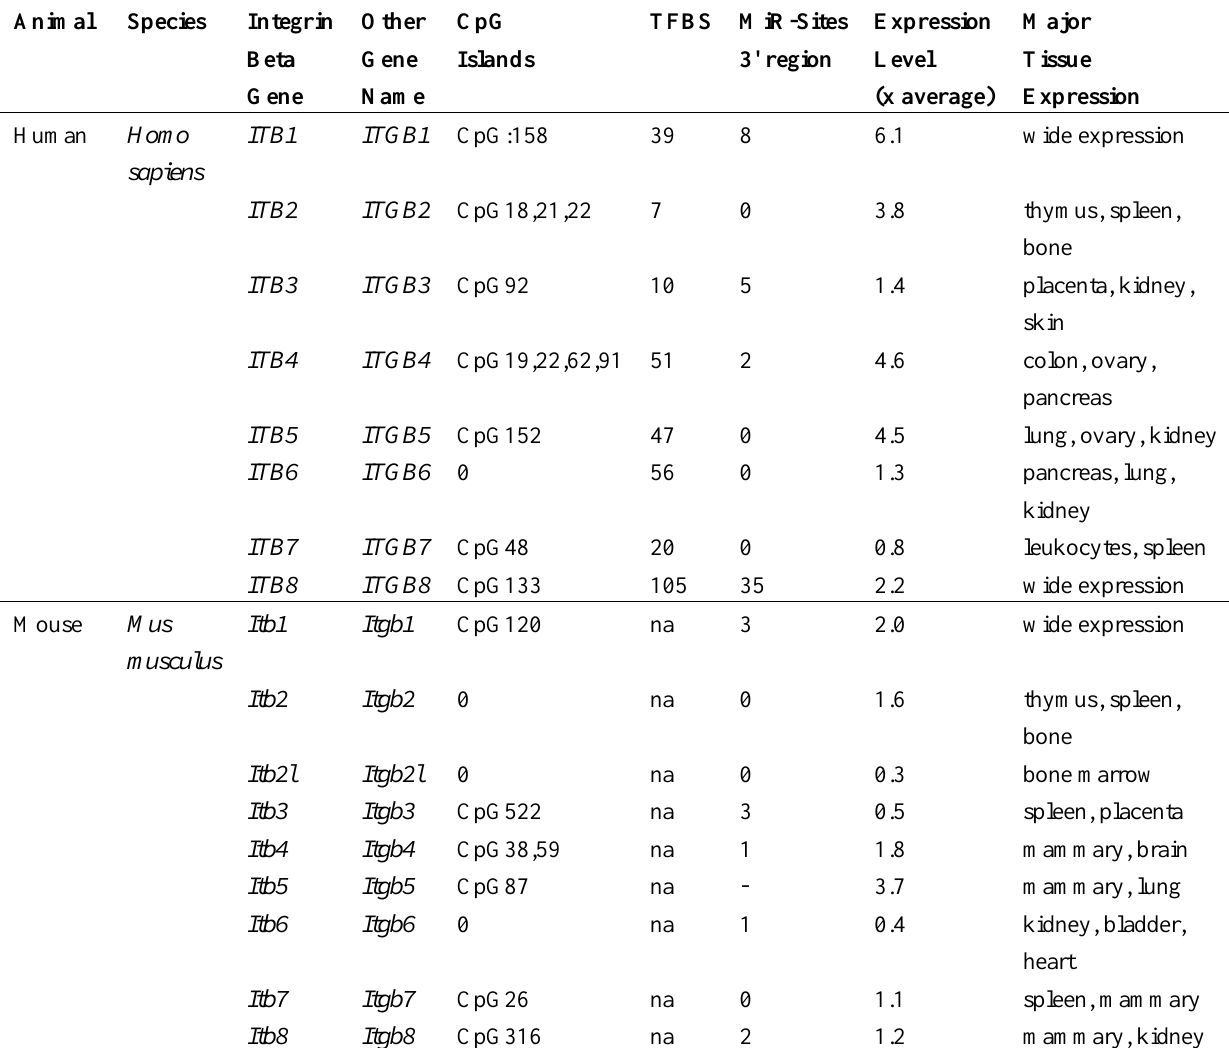
Table 2. Predicted transcription factor binding sites (TFBS), CpG islands and MiRNA (MiR) regions for human and mouse ITB Genes. The human and mouse genome browsers (http://genome.ucsc.edu) [45] were used to examine the predicted transcription factor binding sites (TFBS), CpG islands and Mi-RNA binding sites for human and mouse ITB